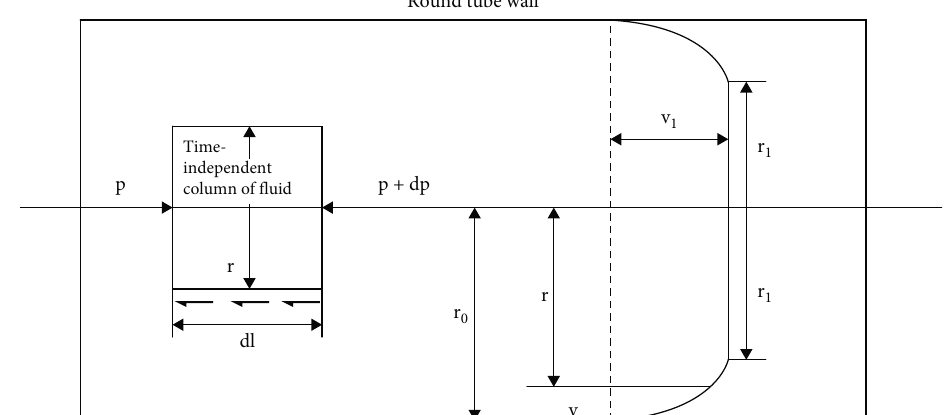
Figure 3: Flow diagram of Bingham fl uid in circular